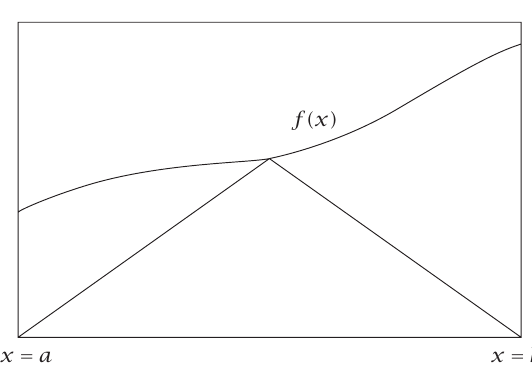
Figure 2.1 . First approximation to the area under f(x) .